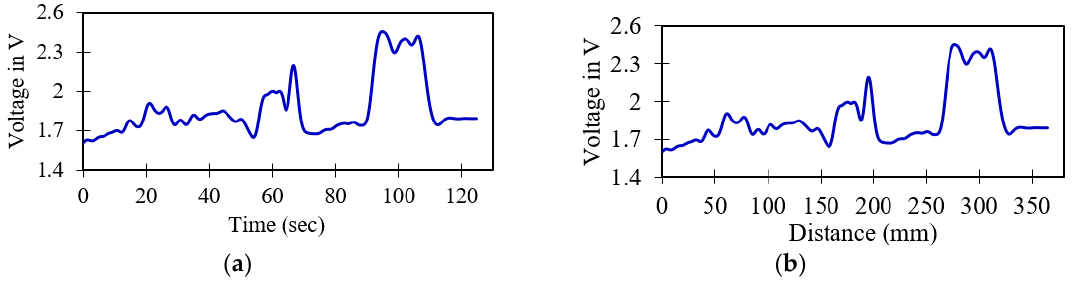
Figure 9. De-noised acquired sensor signal for deposit corrosion defects scanned at 2.9 mm/s for 20-mm lift-off; ( a ) time-domain sensor signal, ( b ) corresponding distance signal.